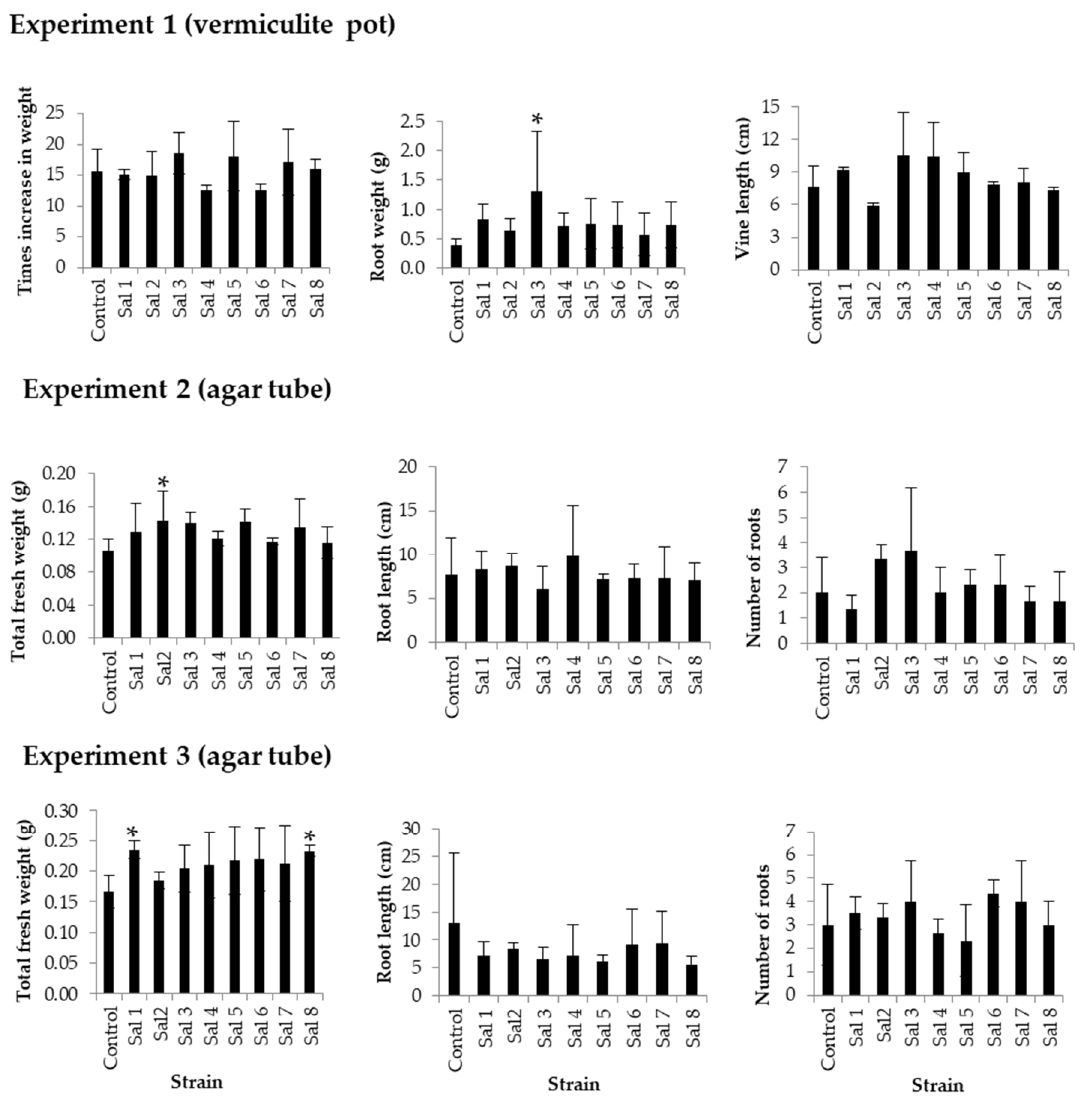
Figure 4. The effect of the inoculation with sweet potato endophytes on sweet potato plant growth in nitrogen non-limiting conditions. The bars represent standard deviation ( n = 3) and asterisks indicate a significant difference from control at P < 0.05 by William’s test.